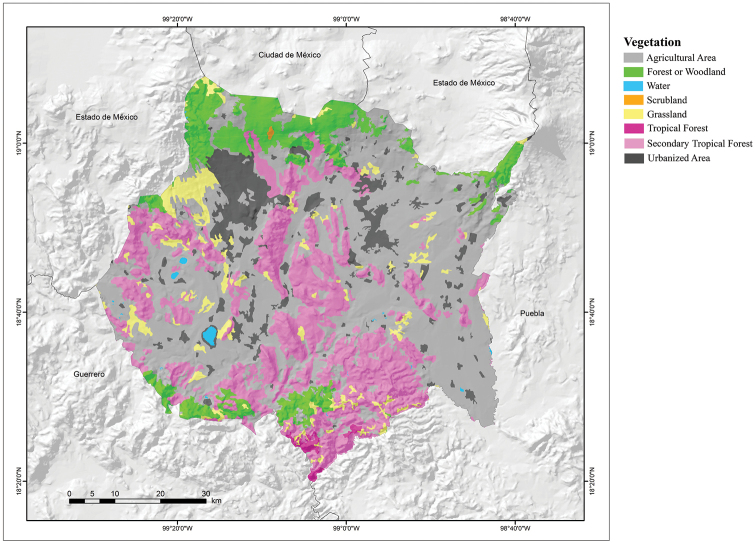
Vegetation map of the state of Morelos, Mexico (modified from Dirección General de Geografía – INEGI 2013).